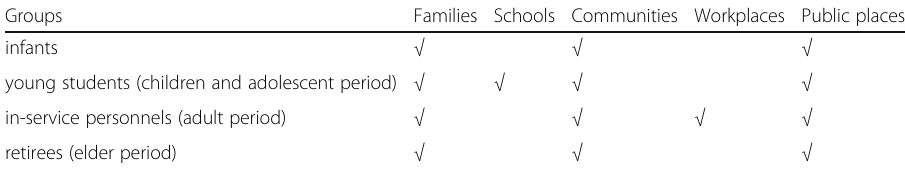
Table 1 Main activity fields for different groups